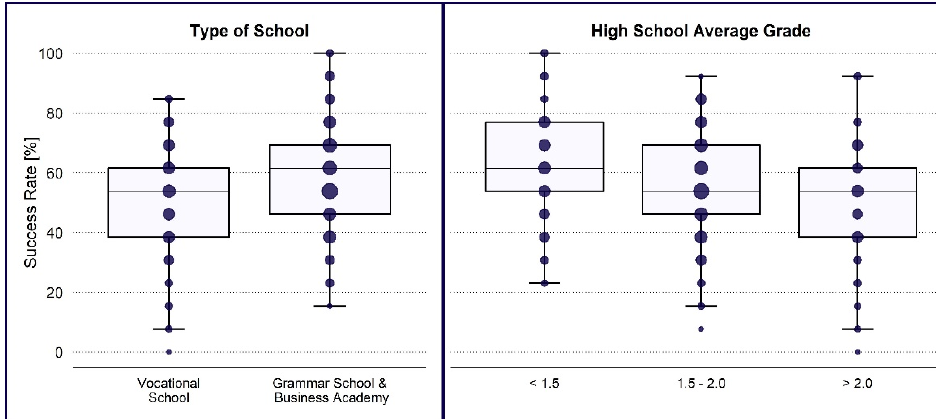
Figure 2. Success rate of students in the financial literacy test depending on the type of high school and their high school performance.